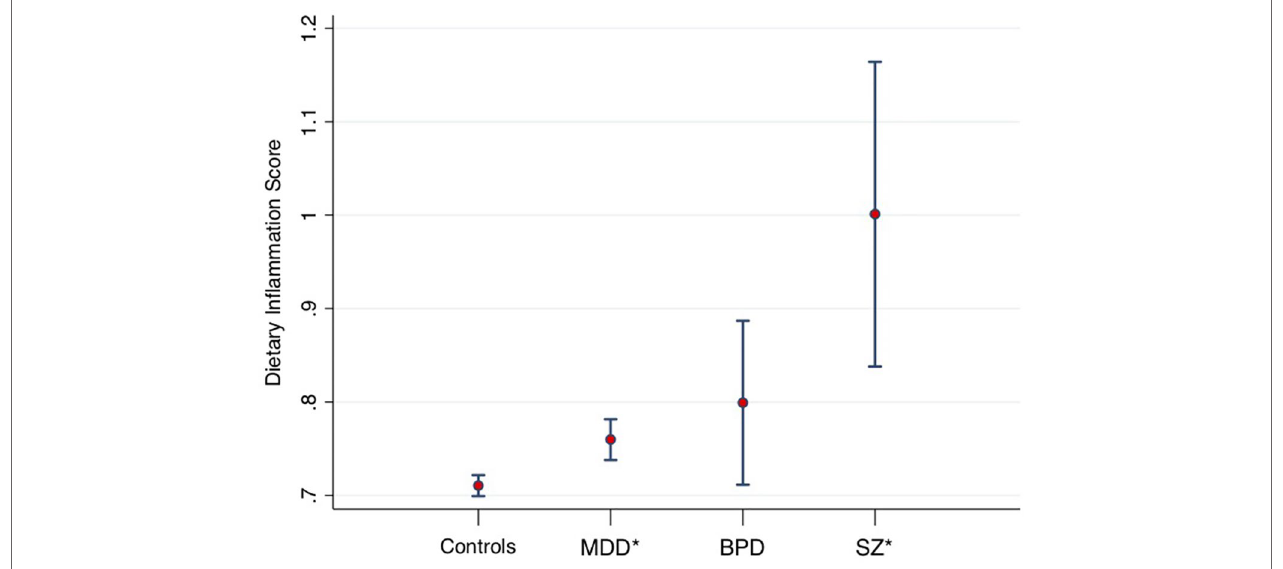
FIGURE 1 | Dietary Inflammatory Index (DII) scores from 53,270 healthy controls, compared to major depressive disorder (MDD) (n = 14,422), bipolar disorders (BPD, n = 933), and schizophrenia (SZ, n = 254). Midpoint shows adjusted means. Error bars show 95% confidence intervals. *Statistically significant difference compared to healthy controls. Data derived from Firth et al.